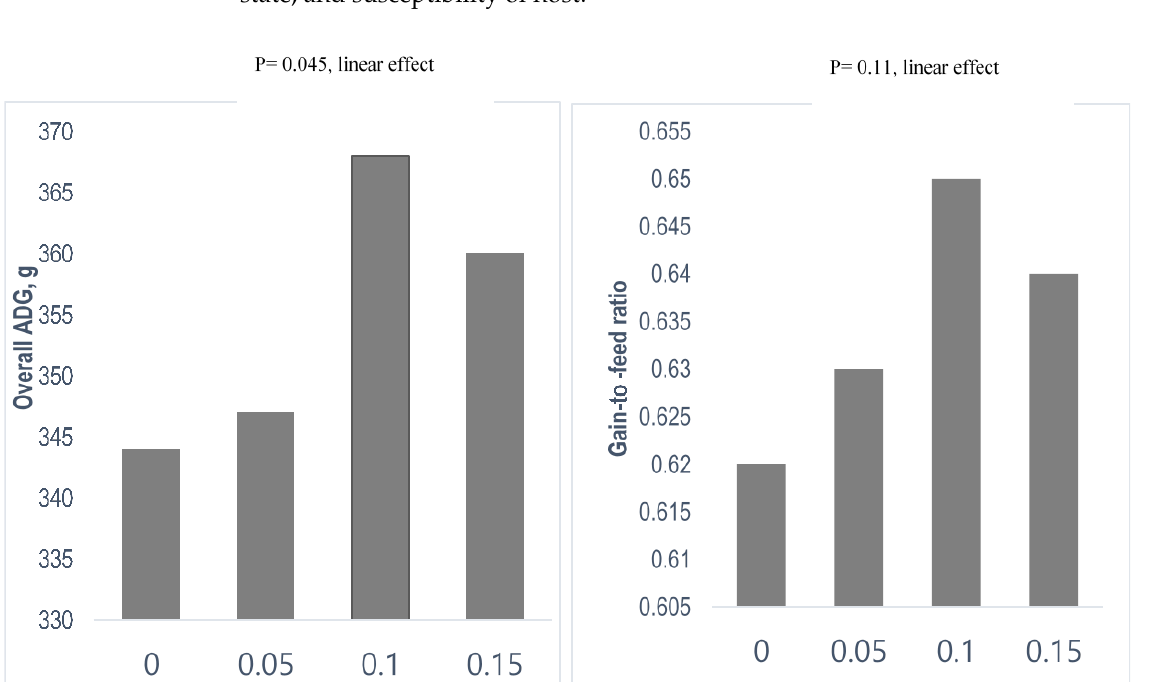
Figure 1. Effect of dietary supplementation of increasing doses of E. cava (%) on overall average daily gain (ADG) and gain-to-feed ratio (G:F) in weaning pigs.